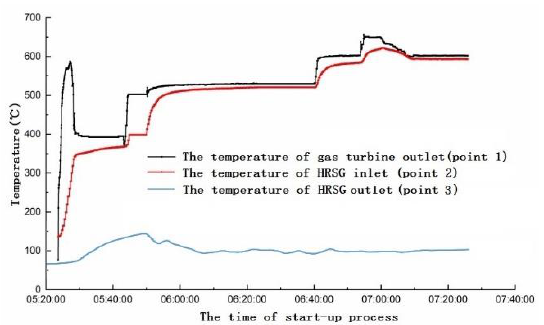
Figure 15. The flue gas temperature of turbine outlet and HRSG inlet.